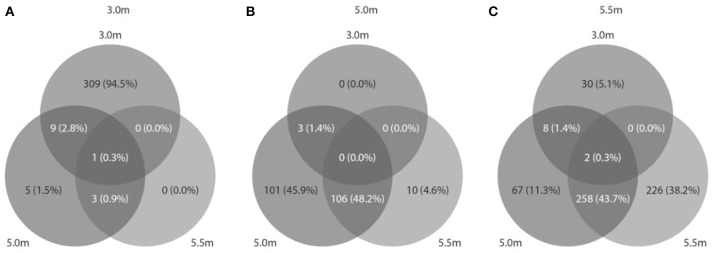
Predicted CRISPRs of microbial metagenomes were blasted against viral metagenomes at the corresponding depth. (A) At 3.0 m: 1094 CRISPRs (327 hits matched); (B) at 5.0 m: 1129 CRISPRs (220 hits matched), and (C) at 5.5 m: 2886 CRISPRs (591 hits matched).